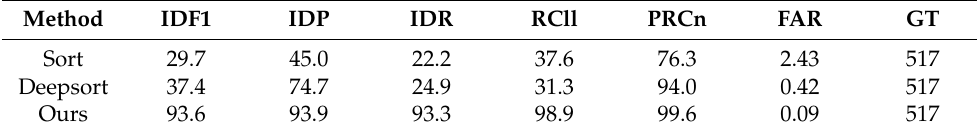
Table 7. Comparison of tracking metrics on MOT16 dataset and deepsort algorithm. Method